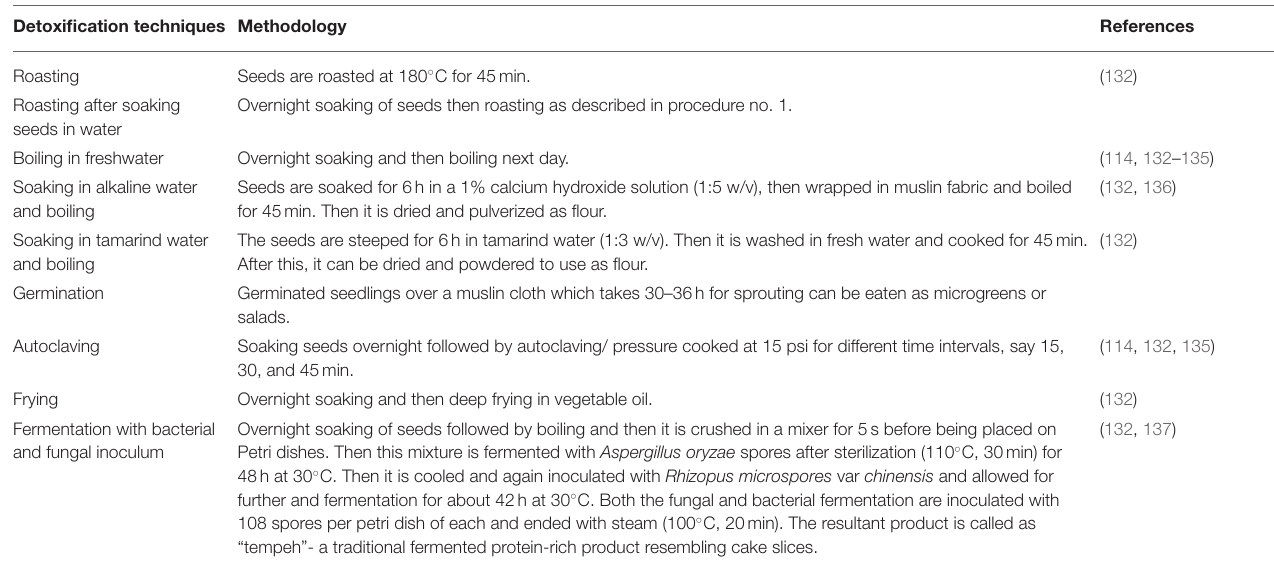
TABLE 5 | Traditional and acquired knowledge based β -ODAP seed detoxifying methods of grasspea. Detoxification techniques